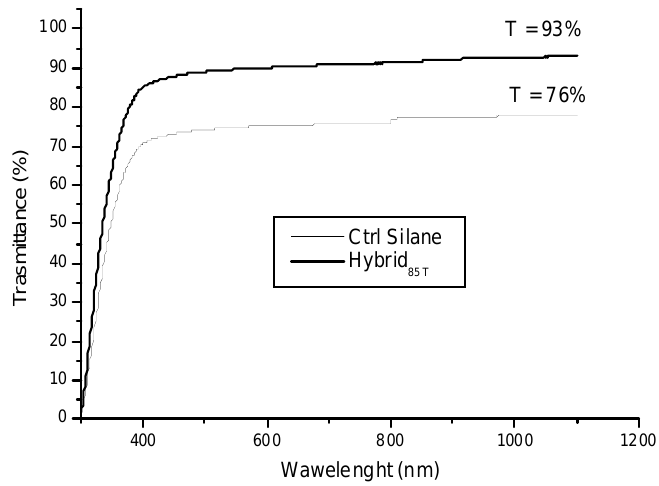
Figure 6. Light transmittance spectra of dual-cured Ctrl Silane and Hybrid